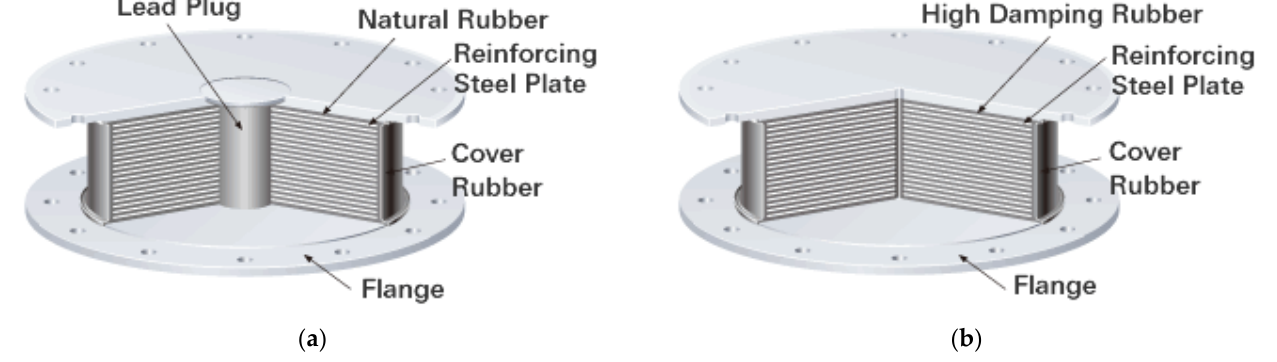
Figure 1. ( a ) Lead–Rubber Bearing. Source: [32]. ( b ) High-damping Rubber Bearing. Source: